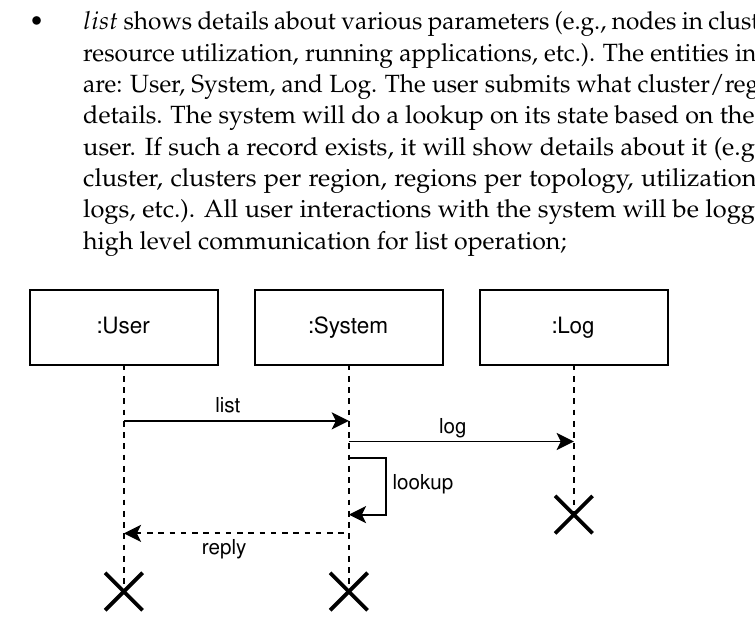
Figure 9. High level list operation